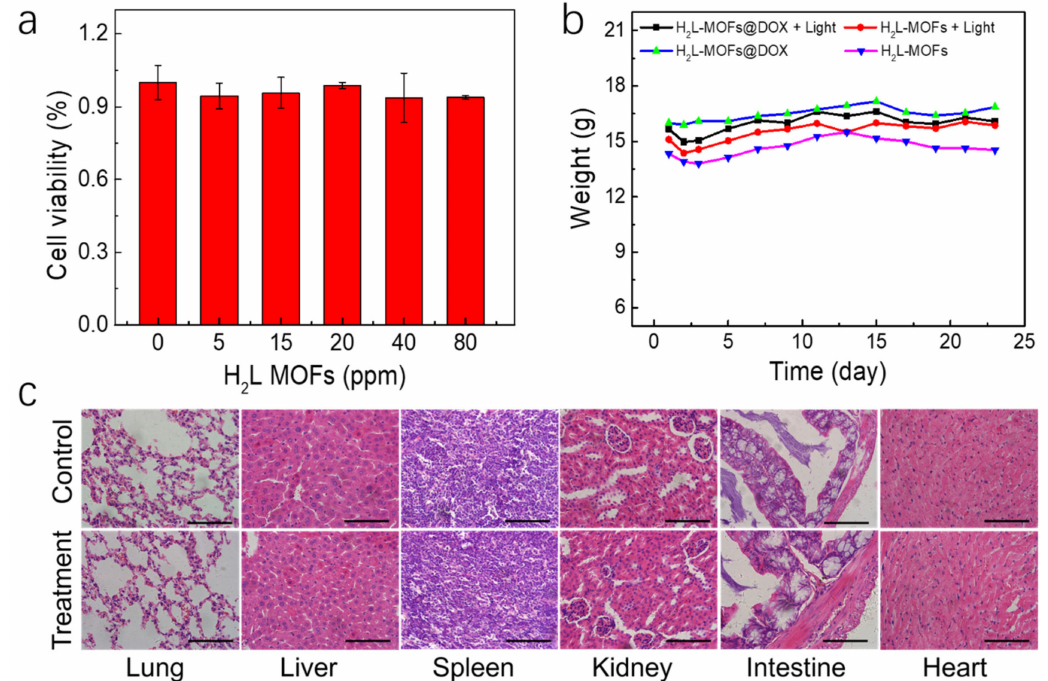
Figure 4. Biocompatibility study of H 2 L-MOF nanoparticles. ( a ) Viability of Hela cells incubated for 8 h in the presence of H 2 L-MOFs with different concentrations. ( b ) The body weight trends of the mice injected with H 2 L-MOFs and H 2 L- MOFs@DOX (20 µ mol Zr per kg). ( c ) Histological images of the lung, liver, spleen, kidney, intestine, and heart of mice after injection with saline solution (control) and H 2 L-MOFs (treatment, 20 µ mol Zr per kg). Scale bars: 100 µ m.